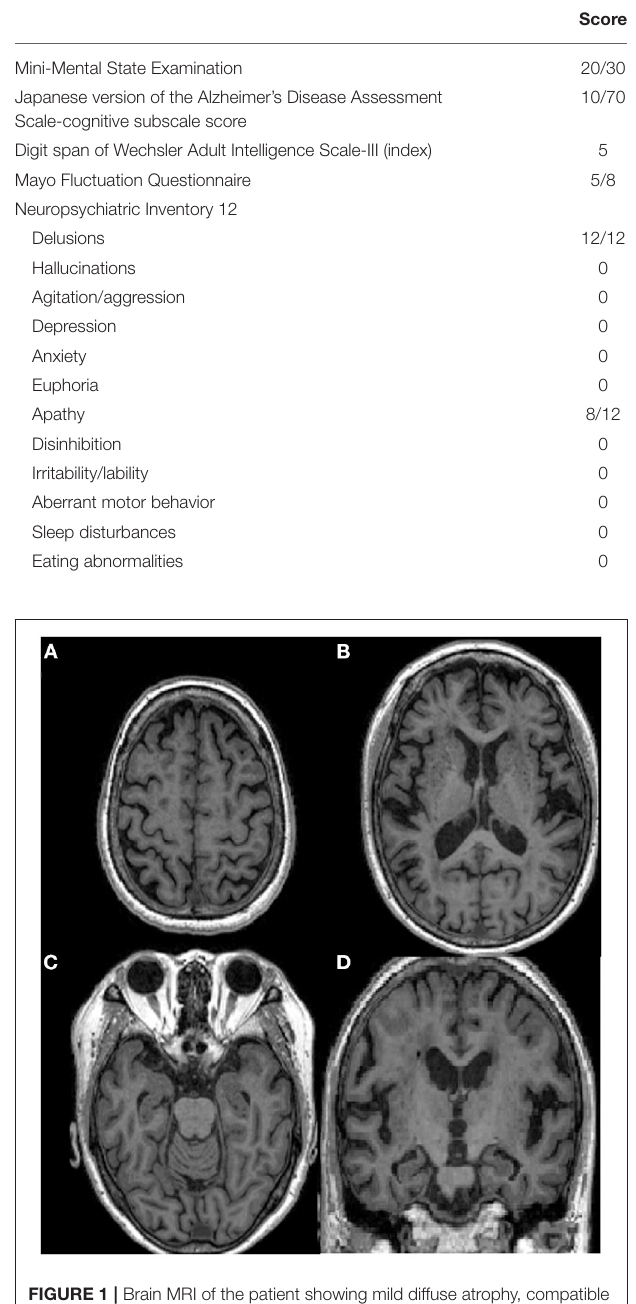
FIGURE 1 | Brain MRI of the patient showing mild diffuse atrophy, compatible with her age. (A–C) Axial sections of T1 weighted images; (D) A coronal